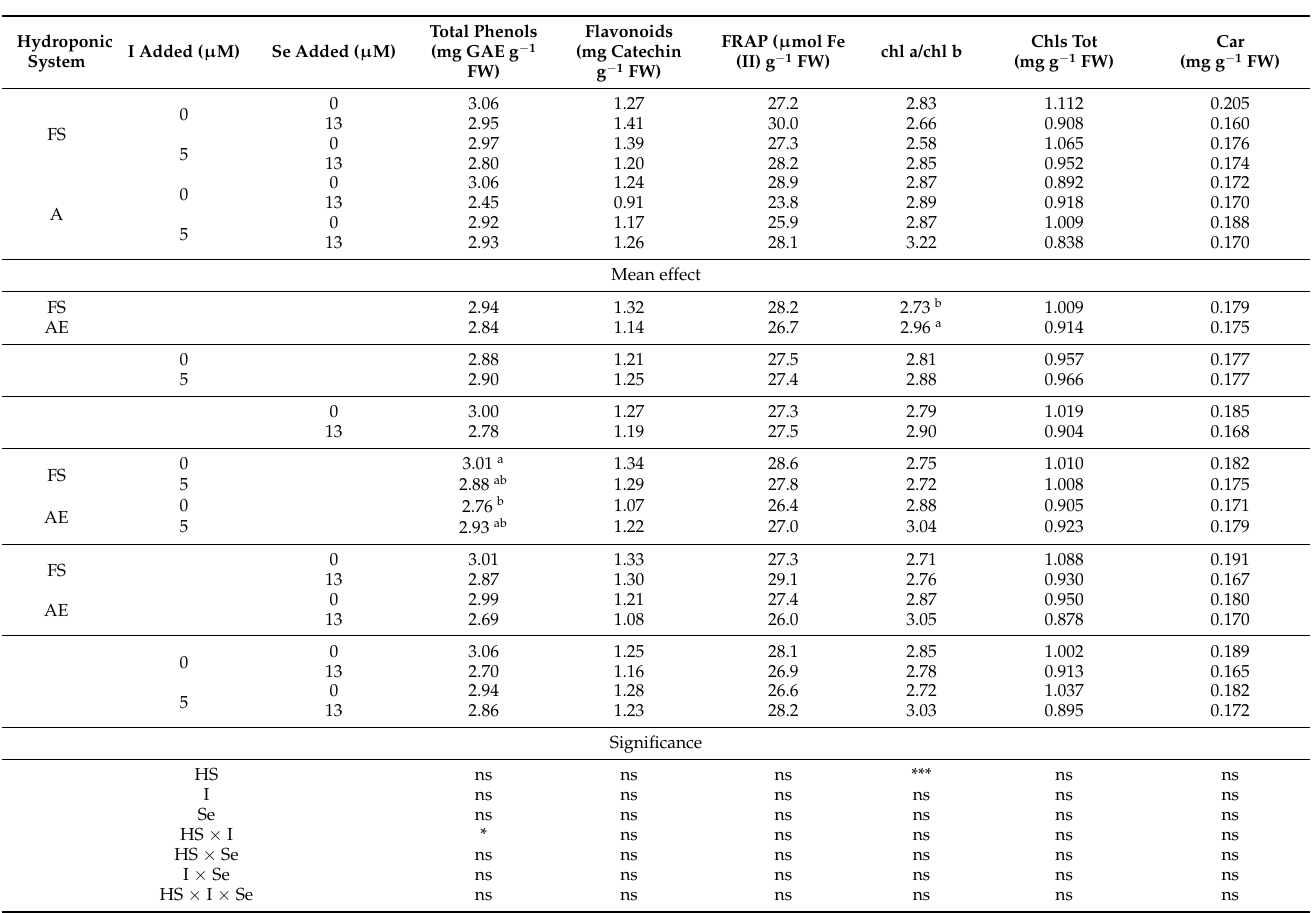
Table 4. Total phenol, flavonoid content, antioxidant capacity (FRAP), chlorophyll a to b ratio (chl a/chl b), total chlorophyll, and carotenoid contents, measured at harvest, in leaves of lettuce plants grown in two different hydroponic systems (HS), floating (FS) and aeroponics (AE), and at different concentrations of I and Se in the nutrient solution, in the second experiment. Hydroponic